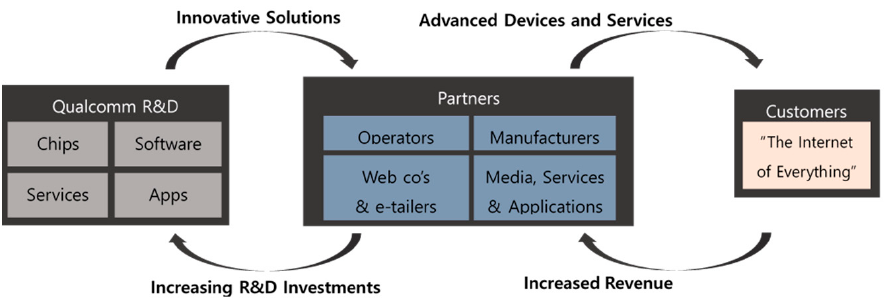
Figure A1. Business Model of Qualcomm. Source: 2009 Annual Report of Qualcomm.